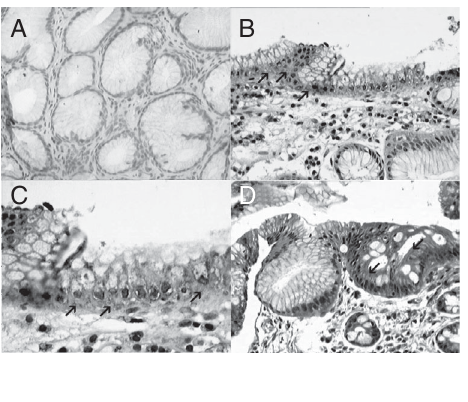
Figure 3. Box-plot showing the average distribution of cyclooxy- genase-2 (COX-2) Yamauchi et al. (21) score in 30 normal speci- mens, 12 ectopic gastric mucosa (EGM) and 10 Barrett’s esopha- gus. (Error bars are ± SD and horizontal lines are medians).